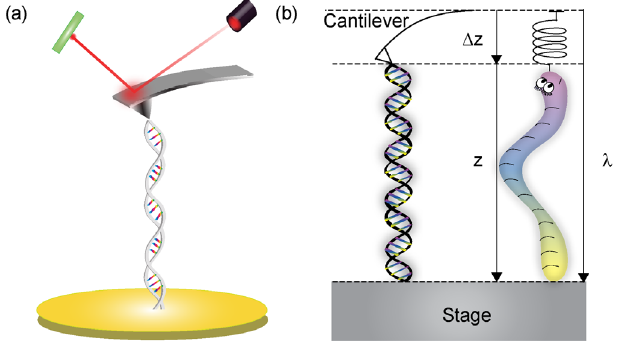
Figure 1. Illustration of a single molecule manipulation experiment using atomic force microscopy (AFM). ( a ) One end of the DNA molecule is attached to a substrate while the other end is pulled by the AFM cantilever tip; ( b ) The cantilever spring obeys Hooke’s law and the elasticity of DNA follows the wormlike chain (WLC) model. The stage position, λ , is related to the molecular end-to-end distance, z , by z = λ – Δ z . Adapted from